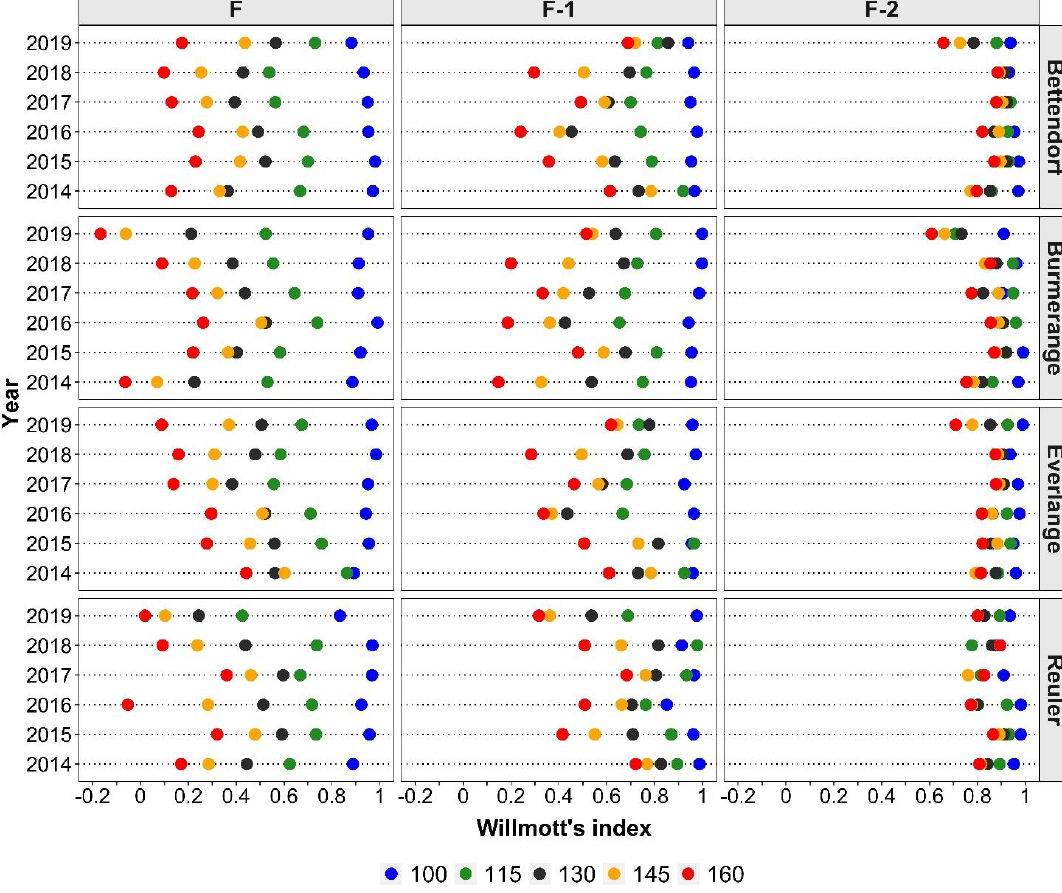
Figure 7. Comparisons of the Willmott’s index values according to the phyllotherms (100, 115, 130, 145 and 160 °Cd) used for predicting the emergence of leaves F, F-1 and F-2 in winter barley at the different study sites in the Grand-Duchy of Luxembourg. F is the flag leaf.